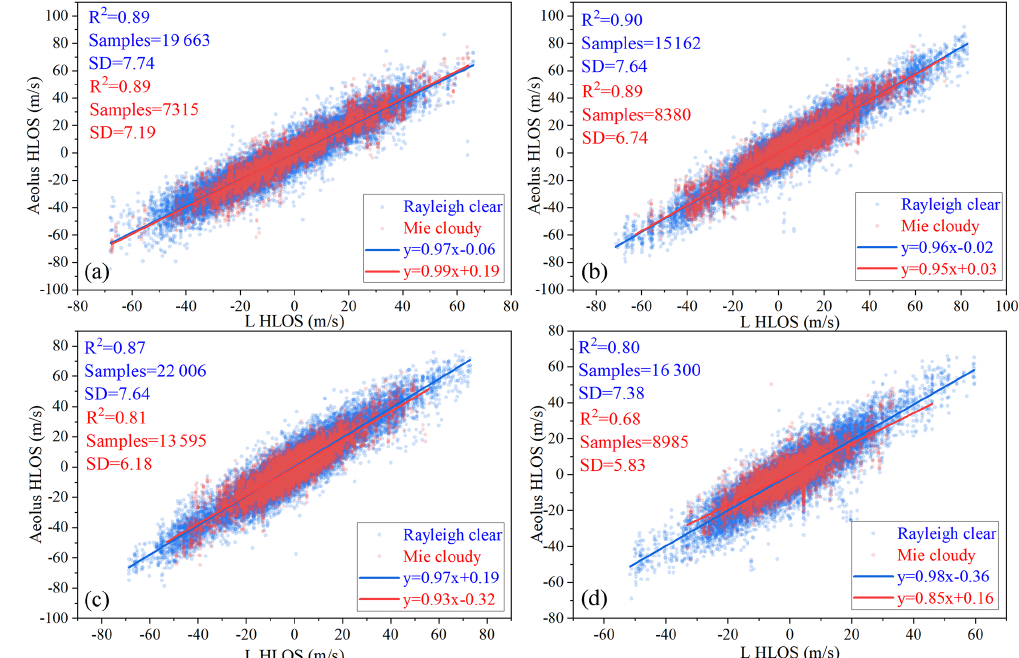
Figure 5. Comparison of Aeolus and L-band radar detection data in four regions. The blue data points are the Rayleigh-clear group data, and the red data points are the Mie-cloudy group data. (a) Chifeng, (b) Baoshan, (c) Shapingba, and (d) Qingyuan. Table 3. Same as Table 2 but for rectangle of ± 1 ◦ lat and long. The distance of 1 ◦ lat and long is approximately 100km in the regions we studied. Aeolus vs. L Aeolus vs. ERA5 ERA5 vs. L